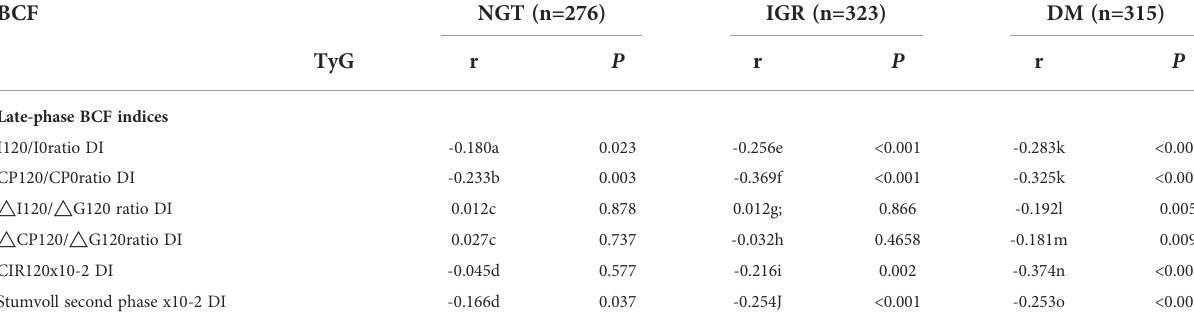
TABLE 5B Correlation coef fi cients between late-phase BCF indices and TyG index in subgroups with different glucose metabolic statuses. BCF